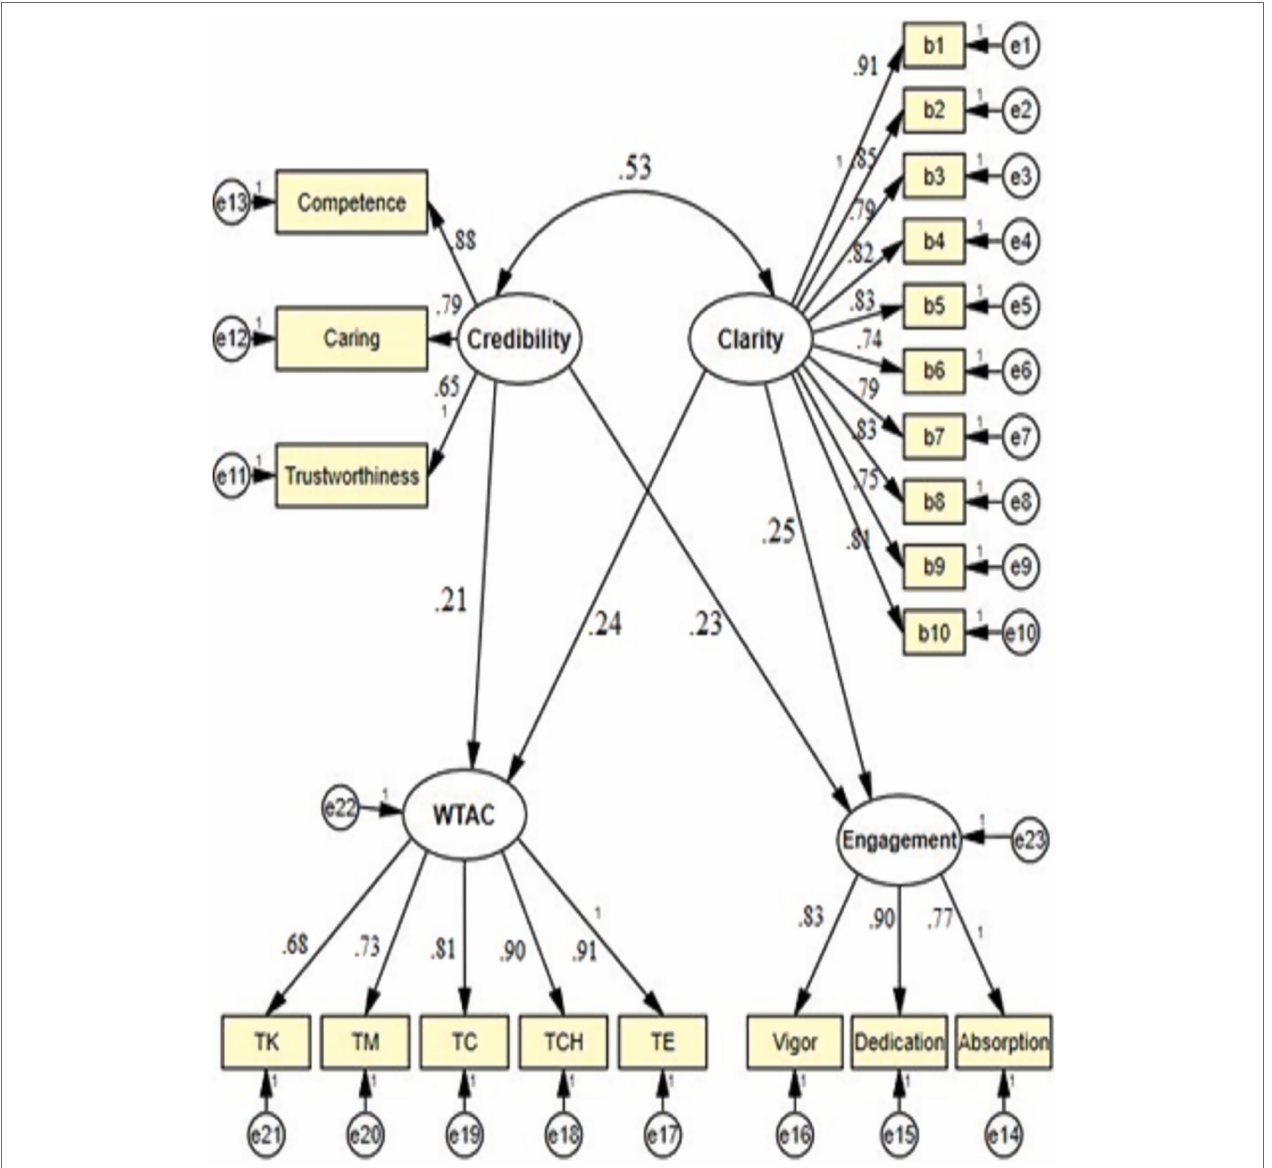
FIGURE 1 | The structural equation model of the interrelationships among teacher clarity and credibility and student academic engagement and willingness to attend